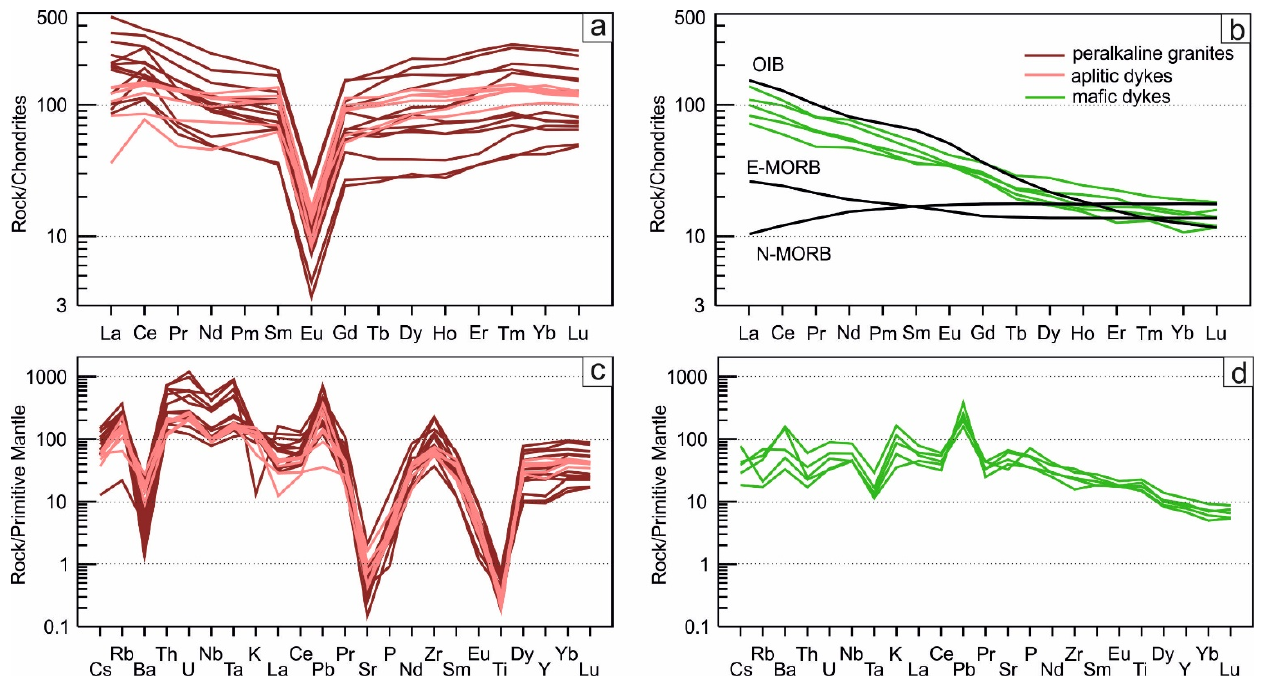
Figure 7. REE ( a , c ) and multi-elemental ( b , d ) patterns of the peralkaline granitic and coeval mafic rocks of the Tannuola terrane, normalized, respectively, to chondrite [44] and primitive mantle [45].